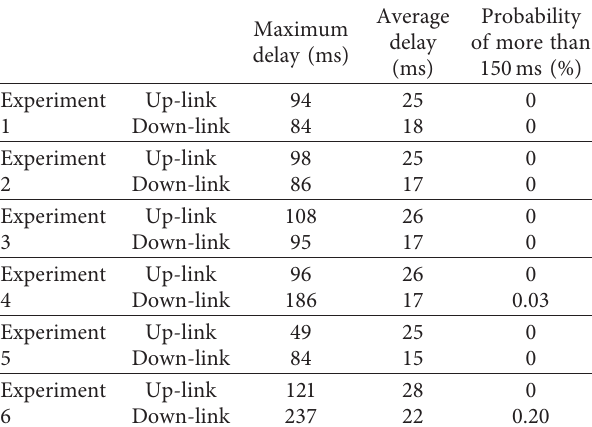
Table 5: Network delay test results of Shanghai